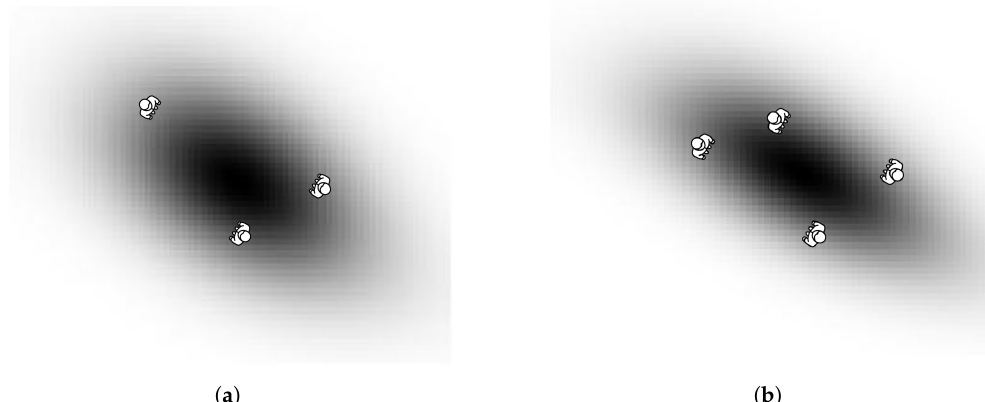
Figure 16. The method group together the different humans under the same Gaussian model. ( a ) Example of a Gaussian generated for a group of 3 people; ( b ) example of a Gaussian generated for a group of 4 people.